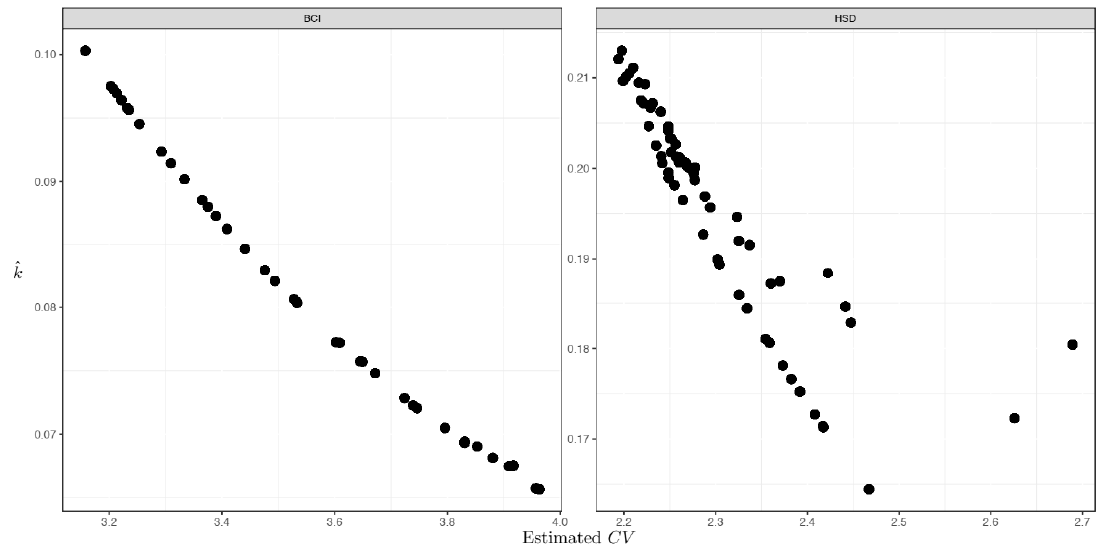
Figure 4. Multiscale relationships between the shape parameter k and CV of species abundances estimated from the randomly sampled local communities in the two permanent forest plots.